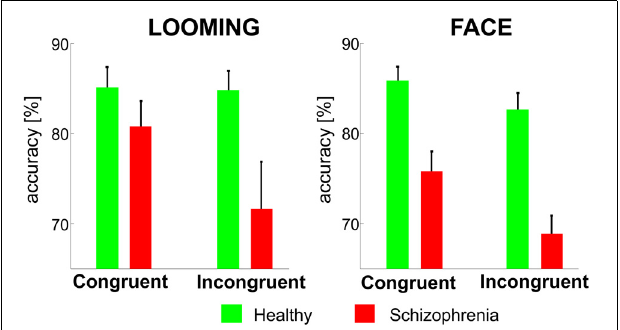
FIGURE 3 | The mean accuracy rates ( ± SE) for the congruent and incongruent conditions in the LOOMING paradigm (left panel) and in the FACE paradigm (right panel) for healthy participants and patients with schizophrenia. In LOOMING, the difference between congruent and incongruent conditions exists only in patients with schizophrenia. In FACE, the difference between the congruent and incongruent conditions exists in both